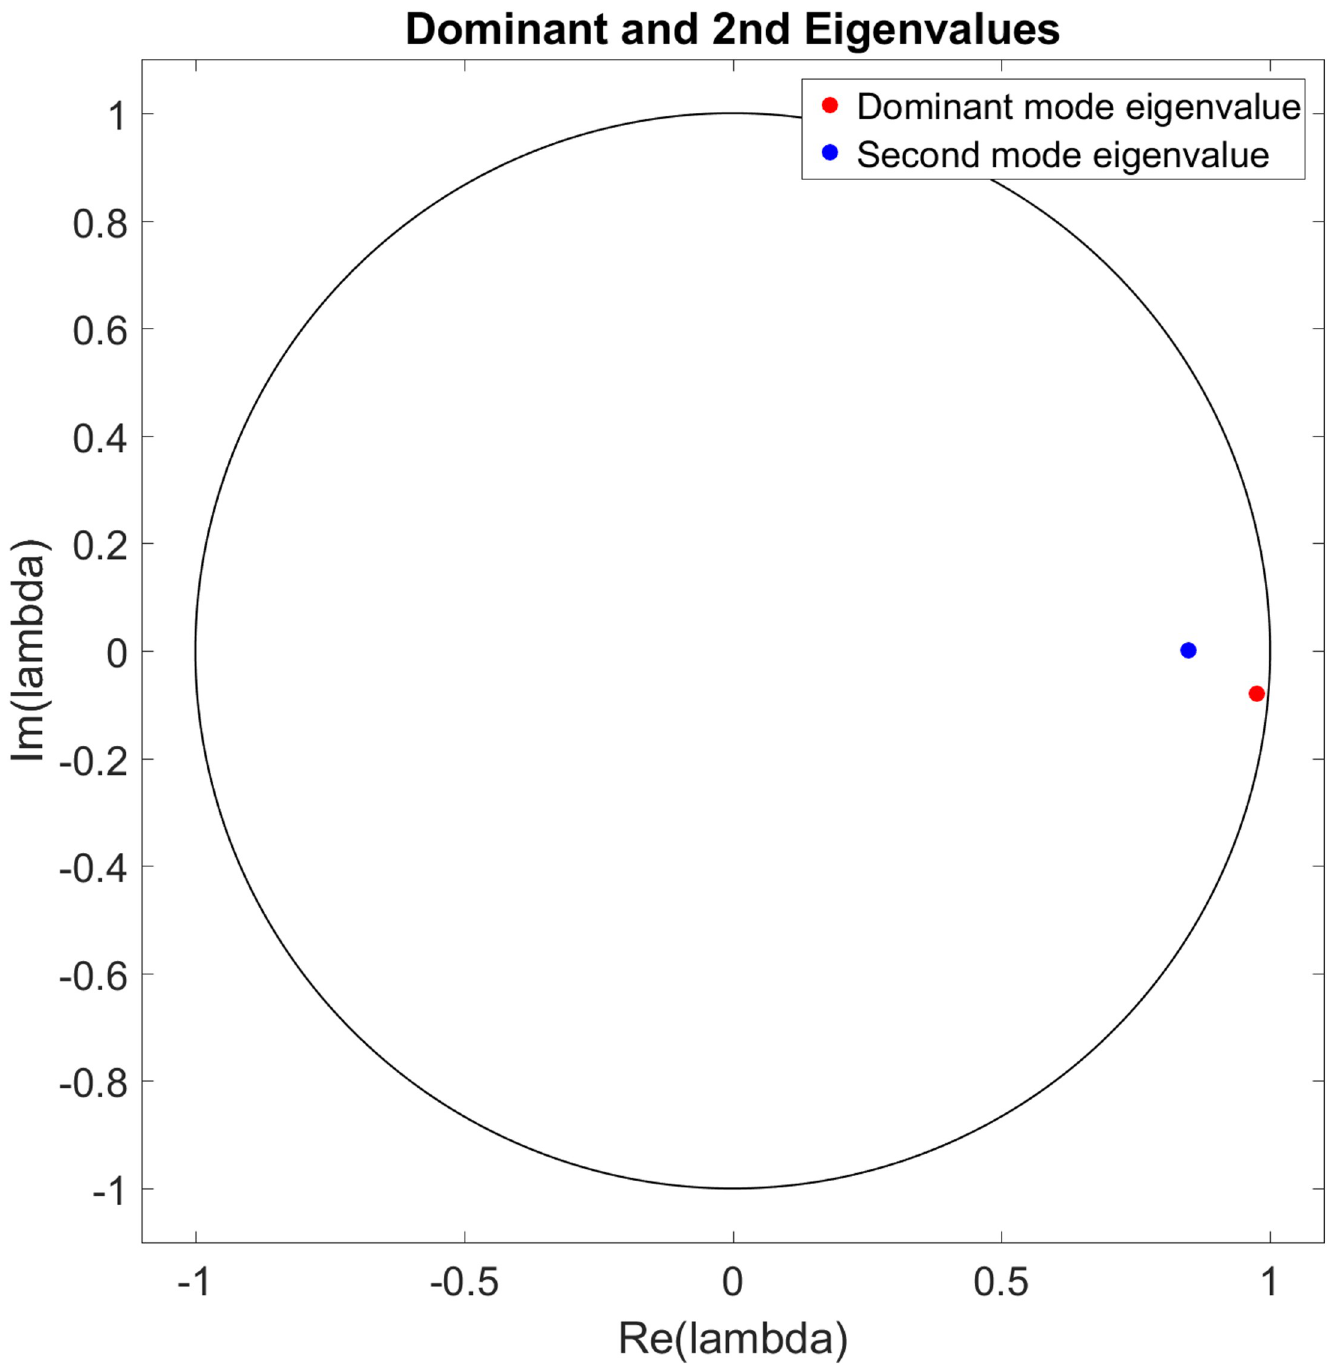
Fig 22. Example eigenvalues of the dominant and second modes from a single simulation for maximum site fuel value of 25 units. The dominant mode eigenvalue is nearly on the unit circle and the real axis, indicating little or no temporal growth/decay or oscillatory behavior, while the second mode eigenvalue is closer to the origin and off of the real axis, indicating long term decay and oscillatory behavior of the associated mode.